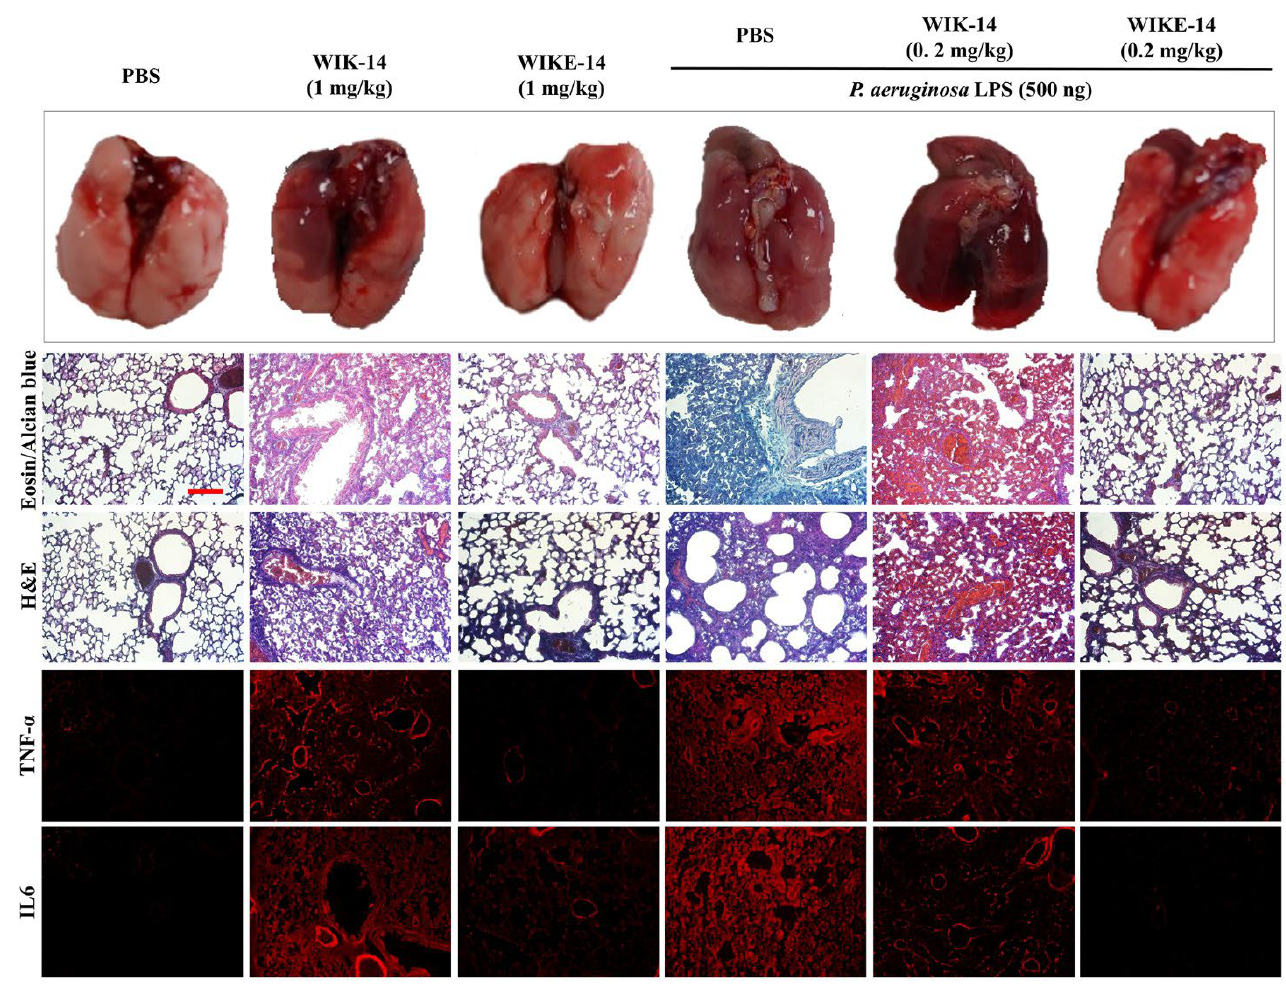
Figure 8. In vivo anti-inflammatory effects of peptides in acute lung injury. Pseudomonas aeruginosa LPS (500 ng) was intratracheally instilled in mice lungs. One hour after instillation, peptides were intratracheally administered, followed by monitoring for 3 days. Lungs collected from the euthanized mice were digitally visualized and tissues were stained using eosin/alcian blue, H&E, PE-conjugated TNF- α, and IL6 antibody. Bar is 50 µm.